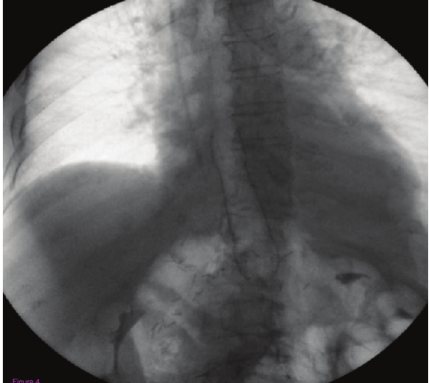
Figure 4: Gastrografin esophagography showing the absence of contrast extravasation, after the placement of the stent.